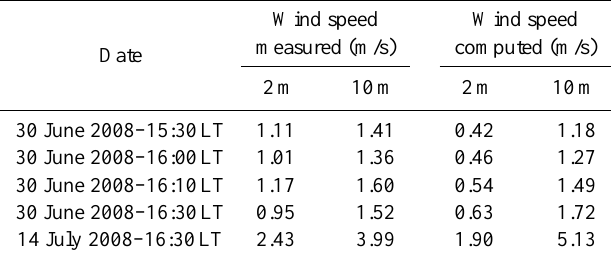
Table 2. Comparison between wind speed measured at the AWS and simulated wind speed values obtained with the CFD